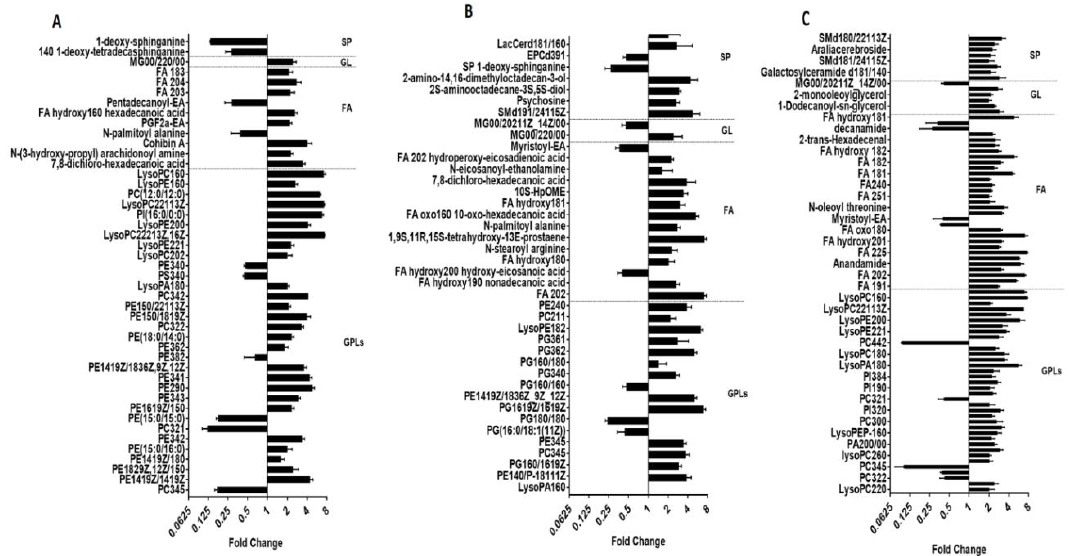
Figure 4. Major differences in the lipid abundance between the OMVs of paired polymyxin-susceptible and -resistant K. pneumoniae isolates. The differences are expressed as the fold-change in the OMV lipids of the paired susceptible vs. resistant K. pneumoniae isolates. All cultures were grown in the absence of polymyxins. ( A ) K. pneumoniae ATCC 700721. ( B ) K. pneumoniae BM3 and ( C ) K. pneumoniae FADDI-KP069. GPLs = glycerophospholipids; FA = fatty acids; GL = glycerolipids; SP = sphingolipids.